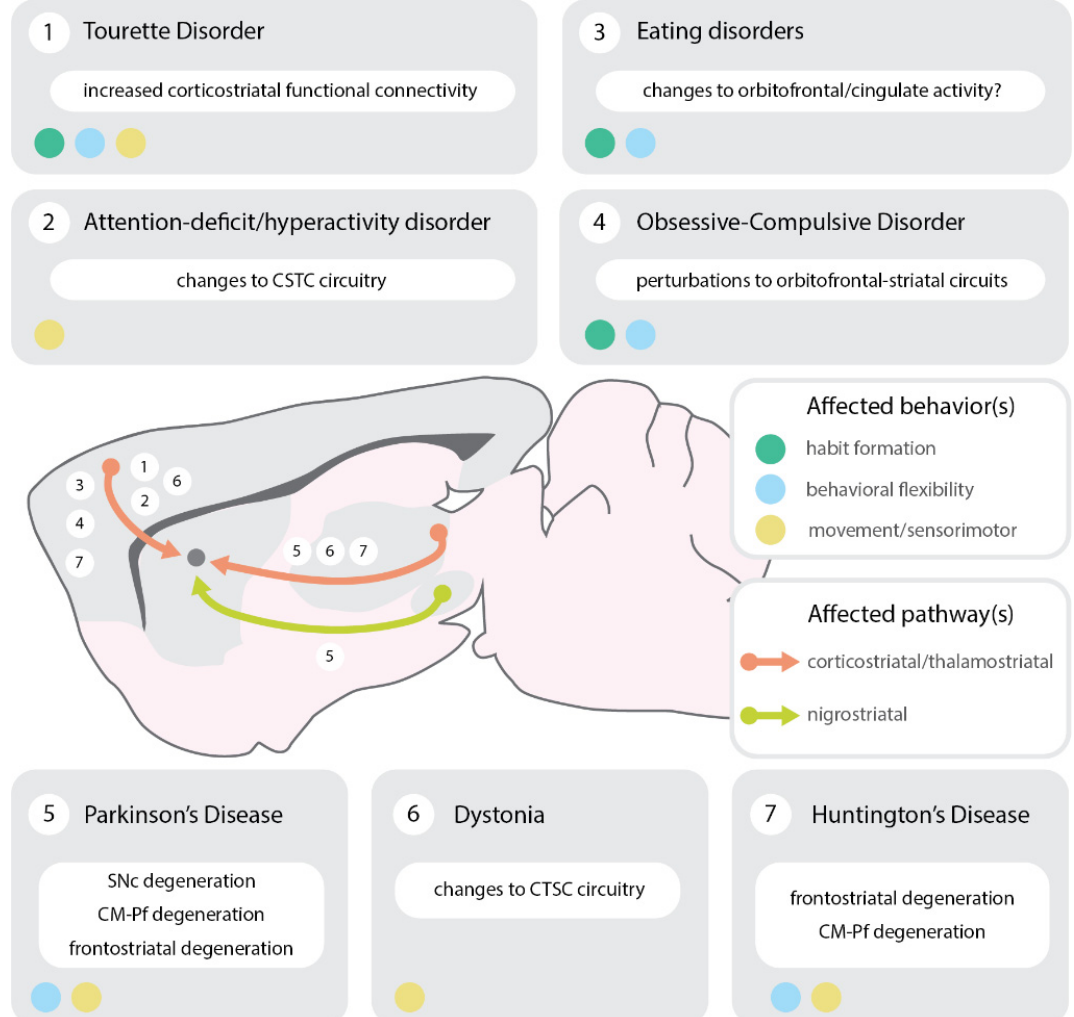
Figure 4. Common circuits and behaviors relevant to striatal cholinergic interneurons are perturbed in common neurodevelopmental, neuropsychological, and neurodegenerative disorders. CSTC = cortico-striatal-thalamo-cortical (circuit); SNc = substantia nigra pars compacta; CM-Pf = centromedian-parafascicular (nucleus); ChIN = cholinergic interneuron. Note: circuits are shown in a mouse brain for illustrative purposes, however, many of these circuits have been shown to be altered in human functional imaging studies.